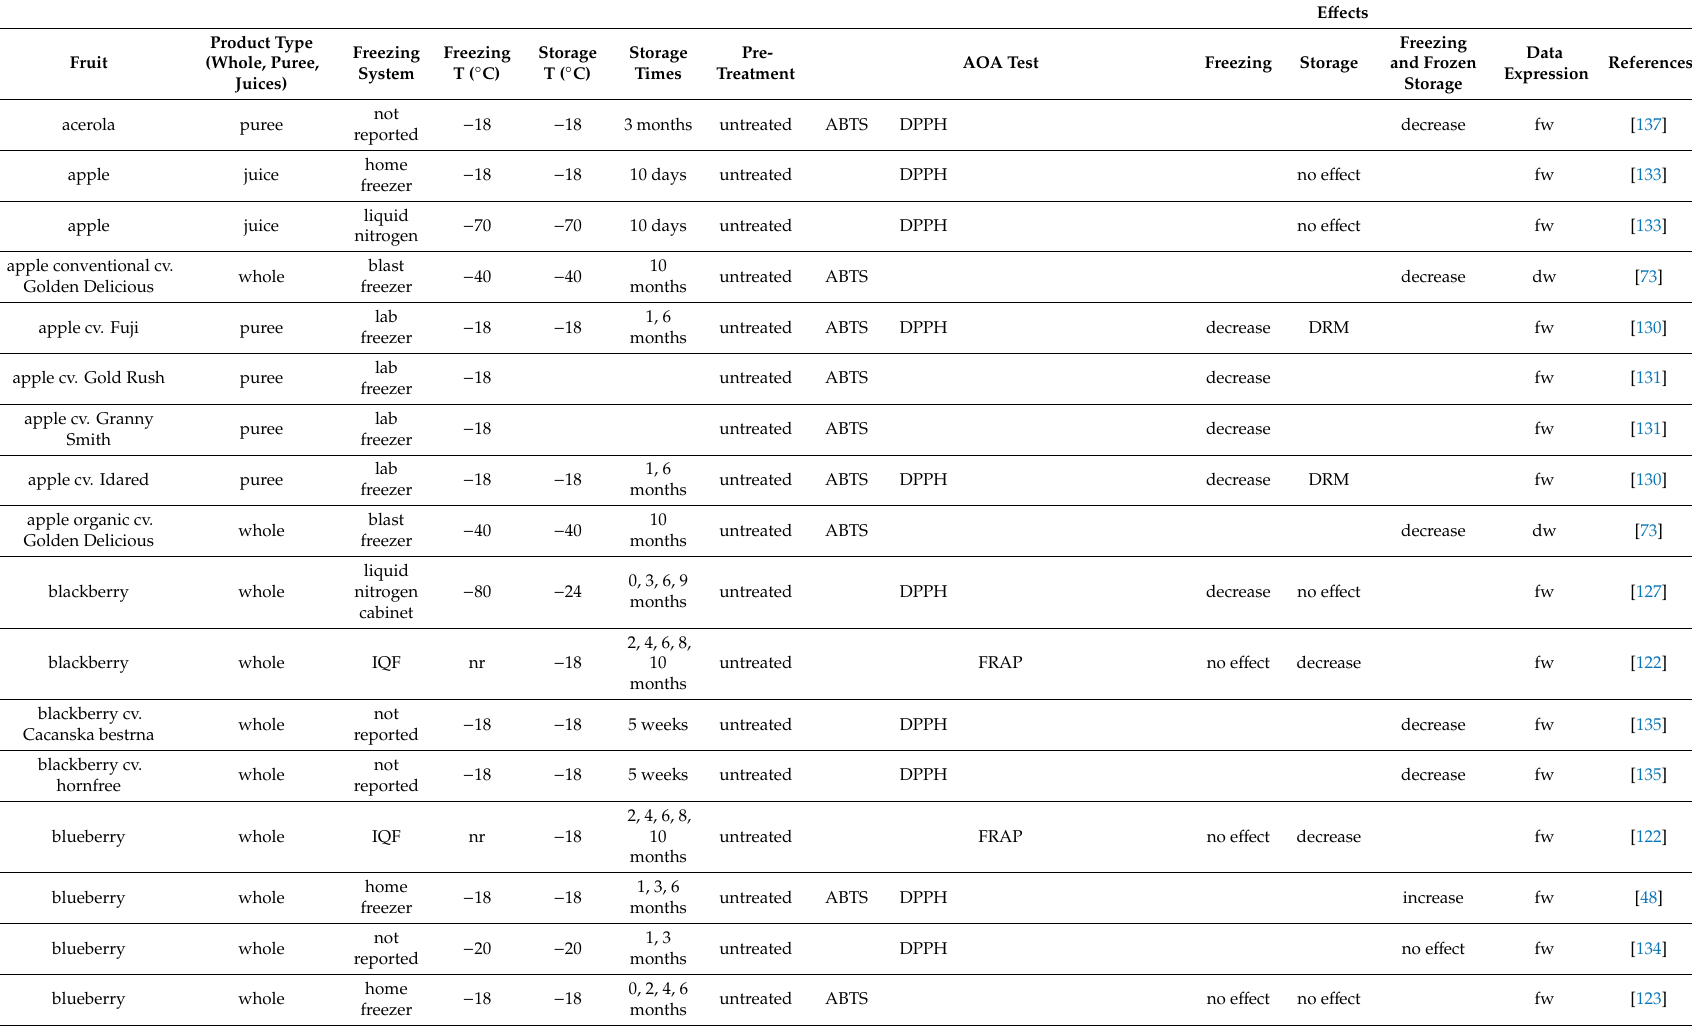
Table 2. Single and combined e ff ect of freezing and frozen storage on the antioxidant activity (AOA) of